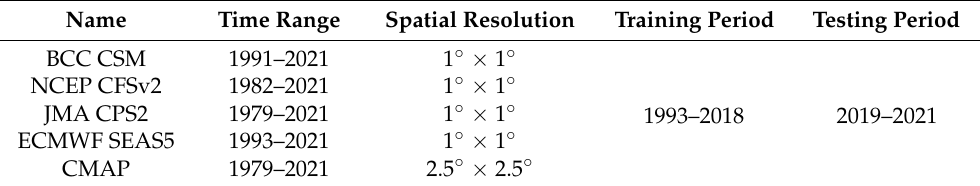
Table 1. Summary of the forecast and observation products used in this